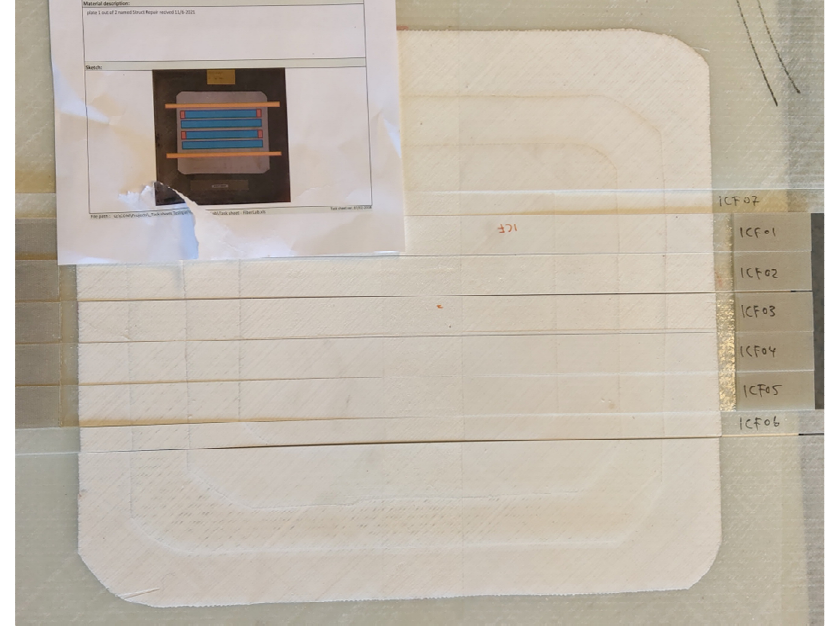
Figure 2. Photo of repaired plate, and geometry of samples to be cut out. Extensometers were mounted on each side of the sample at the center of the repair, to measure the strain between 0–5%. Above ≈ 5% the strain was measured using machine